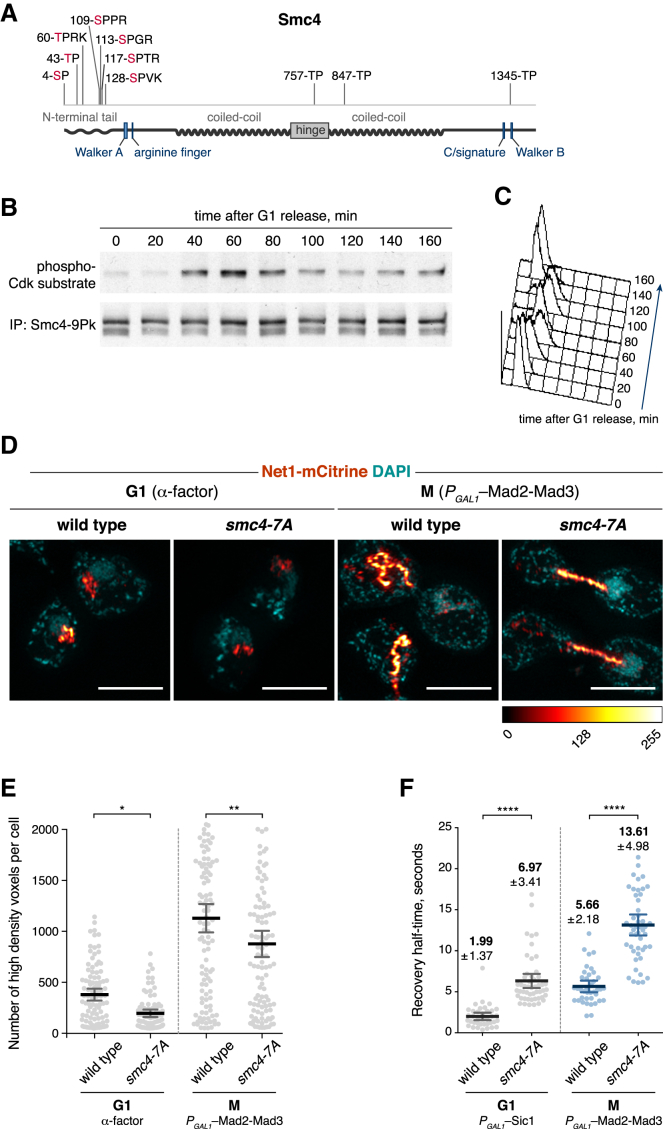
Phosphosite Mutant Smc4 Affects Condensin Dynamics and Chromosome Condensation(A) Schematic representation of Smc4, showing the seven N-terminal Cdk phosphorylation sites.(B) Time course of Smc4 phosphorylation after release from an α factor-induced G1 arrest, assessed by Smc4 immunoprecipitation and probing with an anti-phospho-Cdk substrate antibody.(C) Flow cytometry profiles of DNA content in cells assessed in (B).(D) rDNA morphology of wild-type and smc4-7A cells in G1 or metaphase, visualized by structured illumination microscopy of the rDNA binding protein Net1. Cells were synchronized in G1 with α factor and released into a metaphase arrest. Scale bars represent 4 μm.(E) Quantification of rDNA condensation in smc4-7A cells compared to wild-type in both G1 and metaphase. The means and 95% confidence intervals are presented (n ≥ 80) (ordinary one-way ANOVA, Sidak’s multiple comparison test).(F) Fluorescence recovery half-times, following photobleaching, of the Brn1-3mNeonGreen signal in homozygous diploid wild-type and smc4-7A cells arrested in G1 by overexpression of Sic1 or metaphase by overexpression of Mad2-Mad3. Error bars represent mean ± SD (n ≥ 34) (ordinary one-way ANOVA, Sidak’s multiple comparison test).See also Figure S5 for the identification of Smc4 phosphorylation sites.